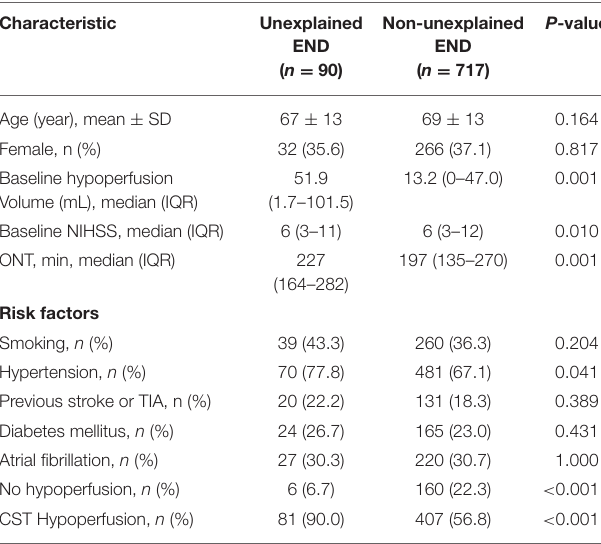
TABLE 2 | Comparison between patients with corticospinal tract (CST) and non-CST hypoperfusion. Characteristic